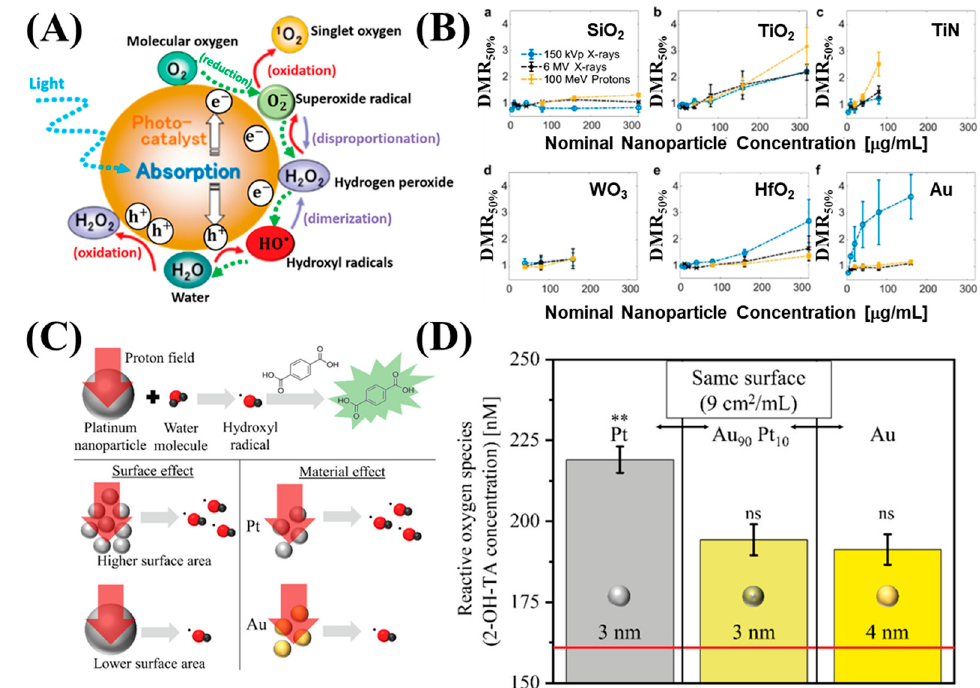
Figure 5. ( A ) A schematic diagram of pathways to generate reactive oxygen species in an irradiated solution containing photocatalytic NPs. ( B ) Radiation enhancement effect of (a) SiO 2 , (b) TiO 2 , (c) TiN, (d) WO 3 , (e) HfO 2 , and (f) AuNPs in HT1080 cells. ( C ) Schematic diagram of hydroxyl radical HO • generation and determination during proton irradiation of surfactant-free NPs. ( D ) Hydroxyl radical generation in Pt, Au 90 Pt 10 , and Au NPs at constant surface concentrations under proton irradiation. Asterisks show the significance of differences between 3 nm Pt NPs and Au 90 Pt 10 and Au NPs using ANOVA analysis. Adapted with permission [77,79]. Wiley, Copyright 2020 and 2021. Adapted with permission [78]. Nature, Copyright 2022.